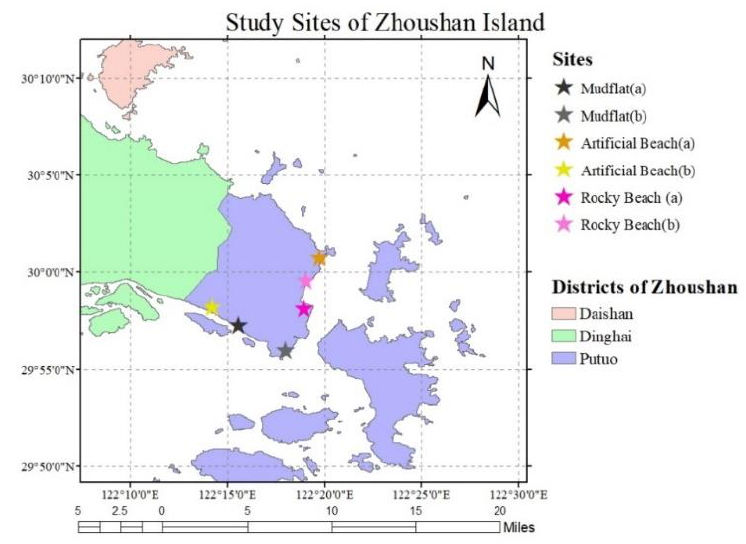
Figure 1. Study sites of Zhoushan Island.